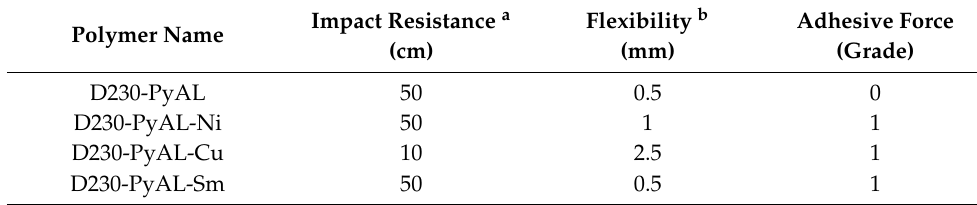
Table 6. The results for flexibility, impact resistance, and adhesive force of D230-PyAL, D230-PyAL-